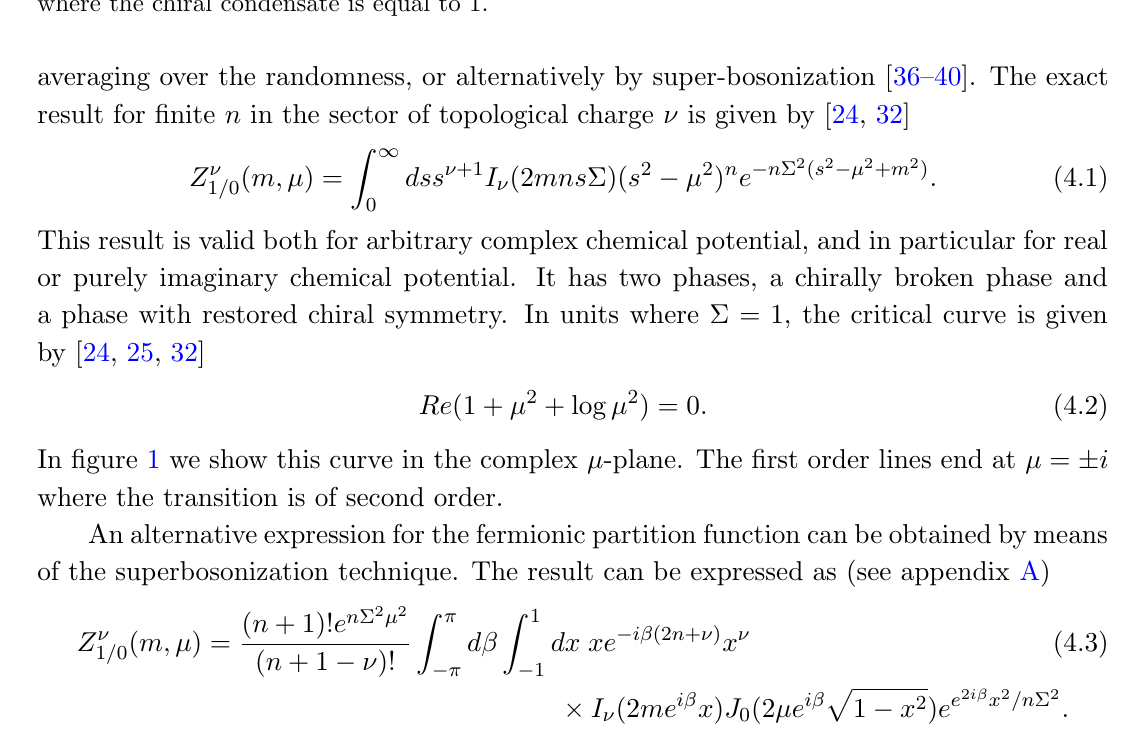
Figure 1 . Phase diagram of the random matrix partition function in the complex (cid:22) plane in units where the chiral condensate is equal to